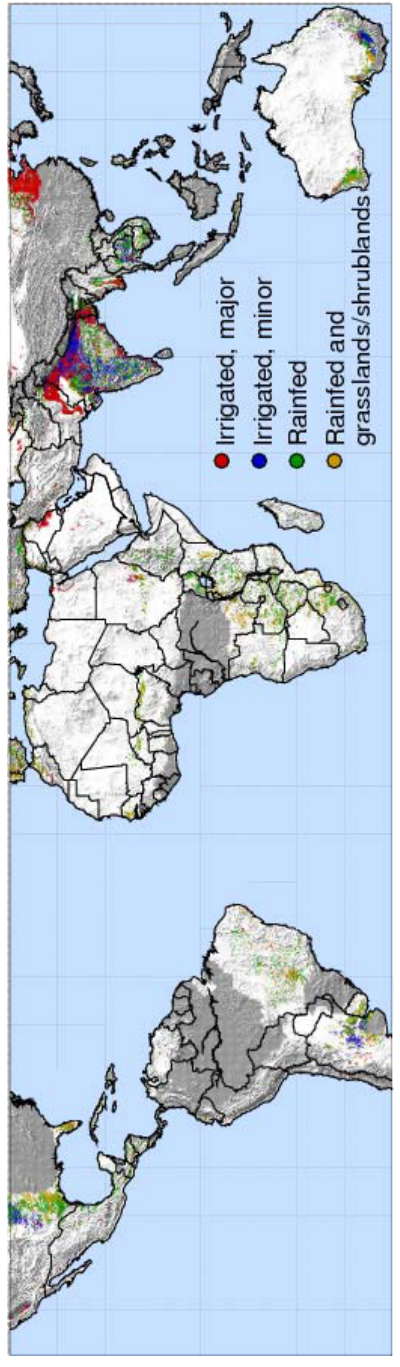
Figure 1. Map of the distribution of irrigated and rainfed croplands in the WLT. Irrigated, major refers to croplands irrigated with surface waters; Irrigated, minor refers to cropland predominantly irrigated with ground water, small reservoir, and tanks. The WLT where the land cover within the grid cell is not dominated by crops are shown in white. Areas outside of the WLT are colored in